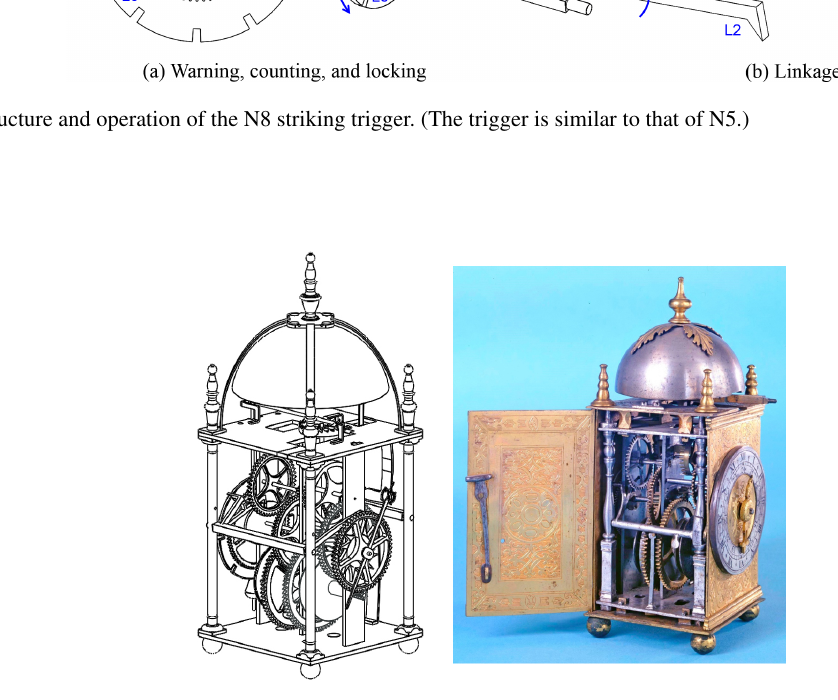
Figure 24. N9 – Lantern clock (James Markwick) (British Museum, 2020a).